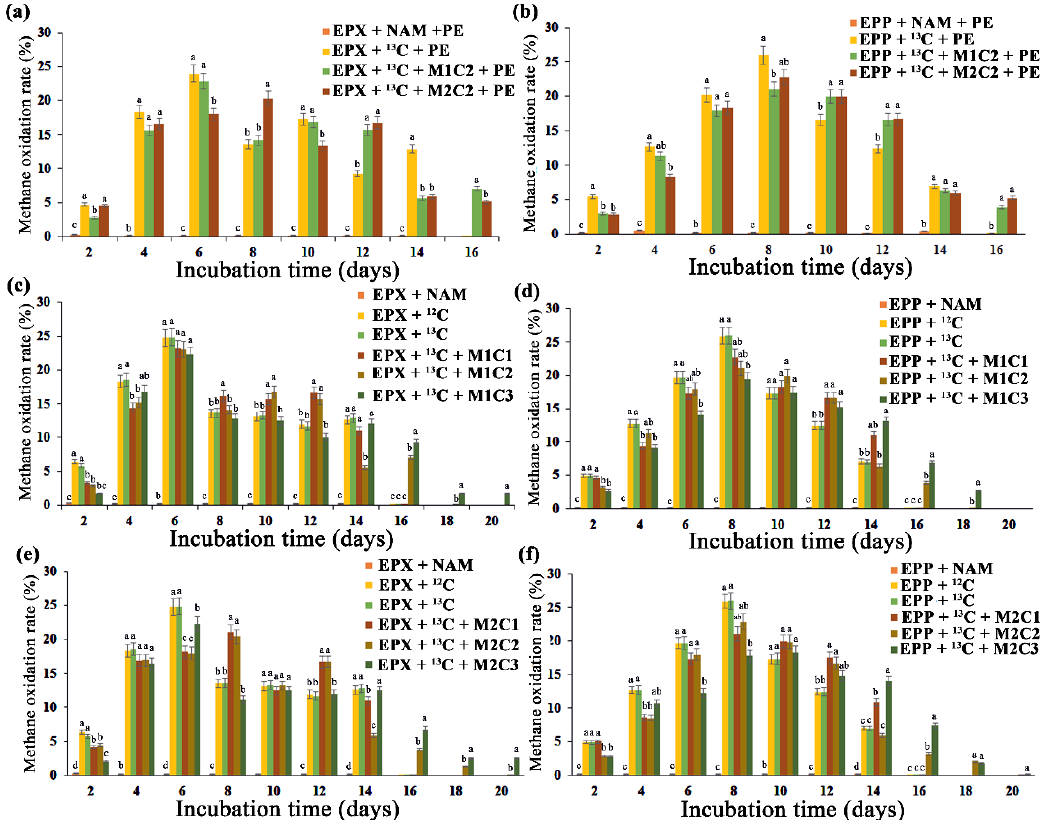
Figure 2. Methane oxidation rate (%) over a period of 20 days. Methane oxidation potential of ( a ) epixylon (EPX) and ( b ) epiphyton (EPP) under discrete concentrations of PE and in combination of both Pb 2+ (M1) and Cd 2+ (M2) at concentrations of 50 mg L − 1 (C2) and PE. Methane oxidation potential of ( c ) epixylon and ( d ) epiphyton under different concentrations of Pb 2+ (C1 = 2 mg L − 1 , C2 = 50 mg L − 1 , C3 = 100 mg L − 1 ) along with controls. Methane oxidation potential of ( e ) epixylon and ( f ) epiphyton under different concentrations of Cd 2+ (C1 = 2 mg L − 1 , C2 = 50 mg L − 1 , C3 = 100 mg L − 1 ) along with controls. Data are expressed as mean ± standard error. The data in a column with a different letter differ significantly at Duncan’s significance level 0.05.